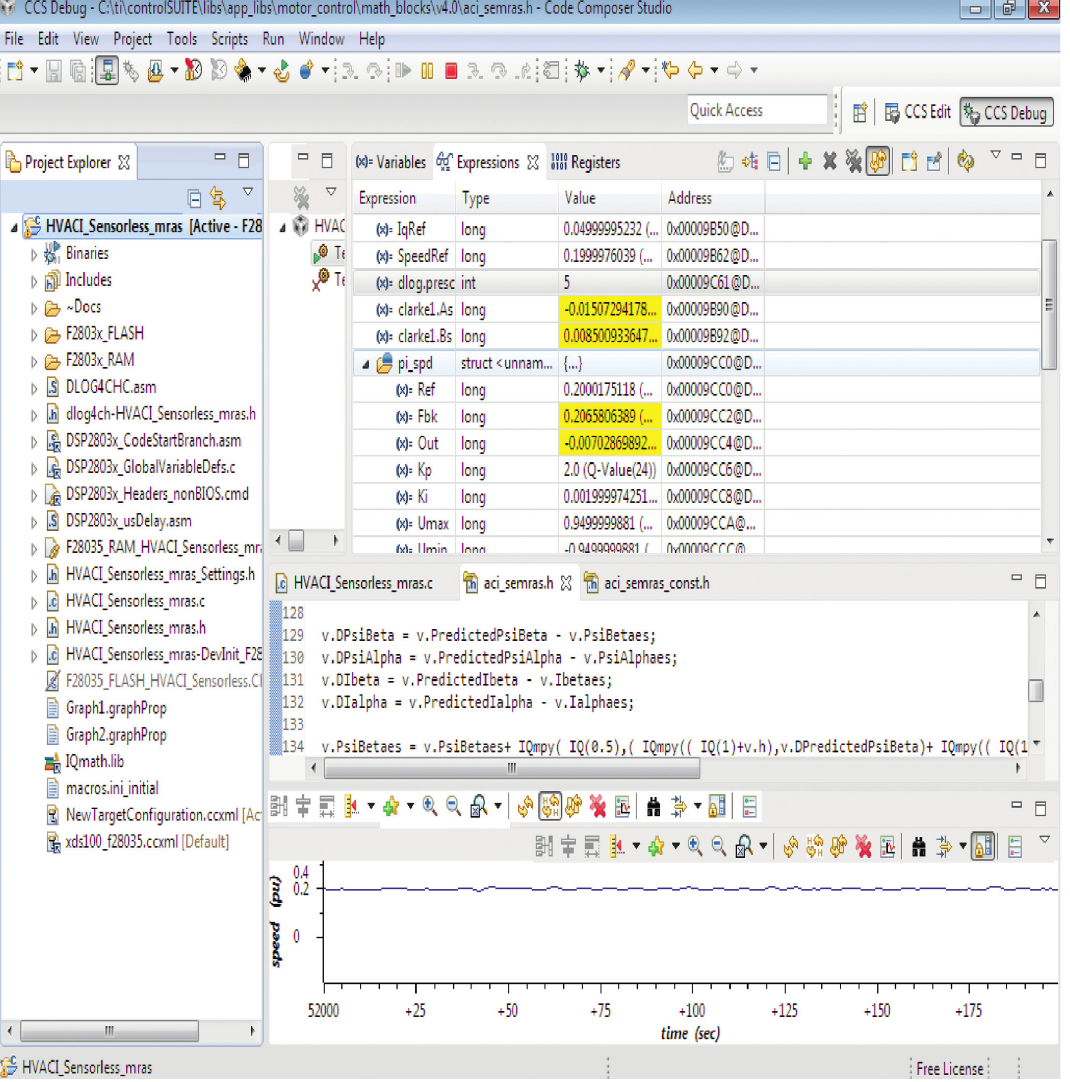
Figure 26: Snapshot of CCS programming interface while the motor is running at